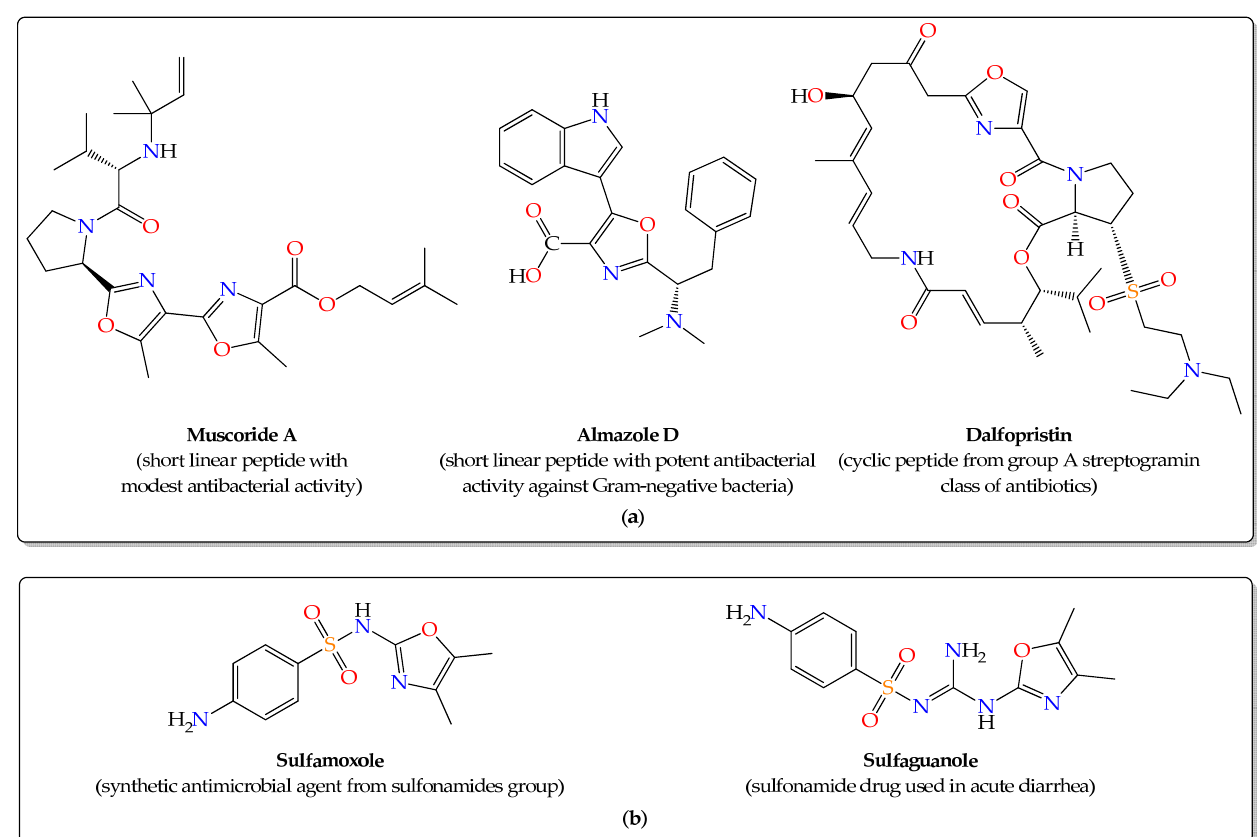
Figure 1. Structures of some representative bioactive compounds sharing the 1,3-oxazole scaffold as antimicrobial agents: ( a ) Natural or semi-synthetic products; ( b ) Synthetic compounds. The isolable 5-keto-tautomers of 1,3-oxazol-5-ols are 5-oxo-4,5-dihydro-1,3-oxazoles,